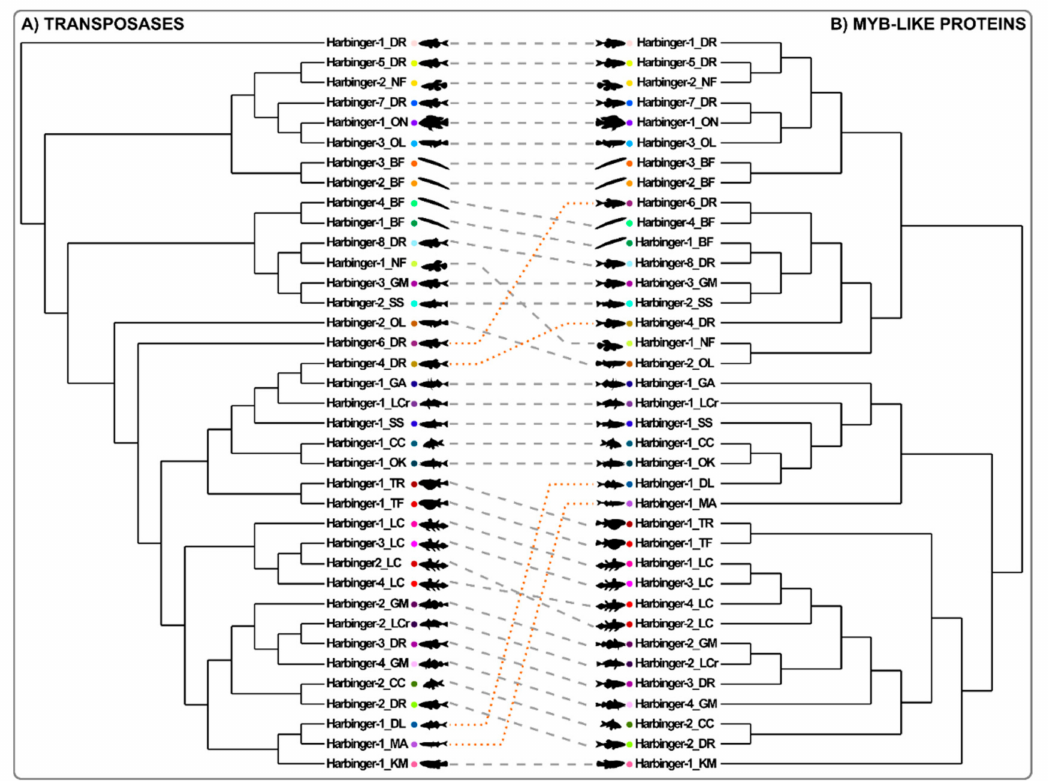
Figure 5. Phylogenetic congruence between transposases and Myb -like proteins of Harbinger trans- posons from fish genomes. The trees of the transposases ( A , cf. Figure 4A) and Myb -like ( B , cf. Figure 4B) proteins were constructed using the Bayesian method [35]. The correspondence of the transposases and Myb -like proteins from a same Harbinger element are indicated with colored dots and connected by dashed lines. Non-congruent elements are indicated with orange dashed lines. See the legend of Figure 4 for species name